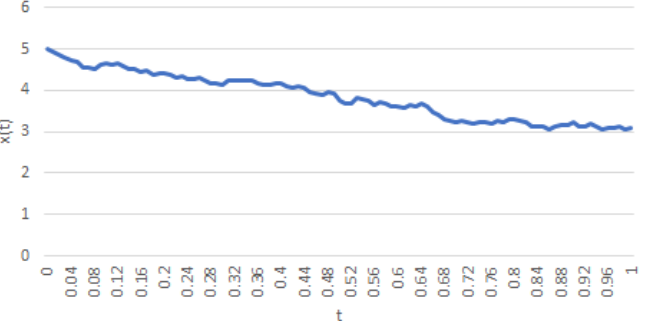
(cid:112) x ( t ) , T = 1,